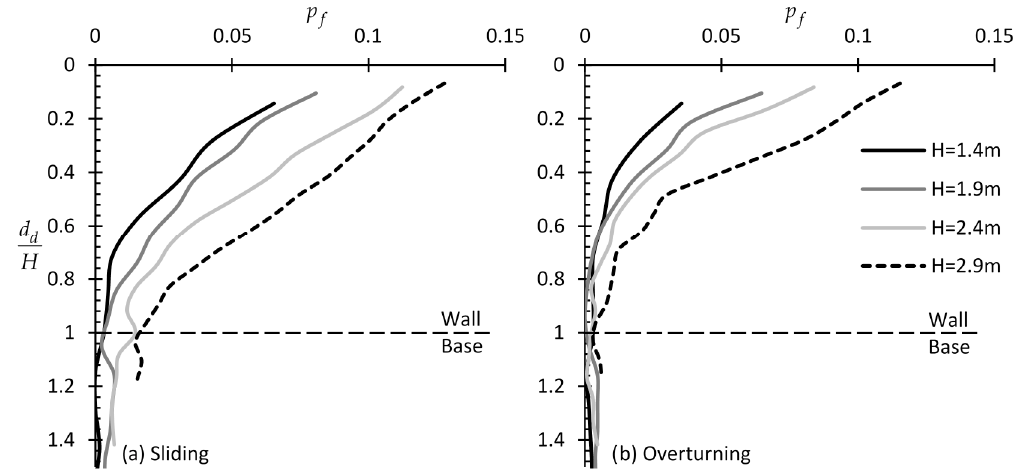
θ= and different wall heights for the ( a ) sliding